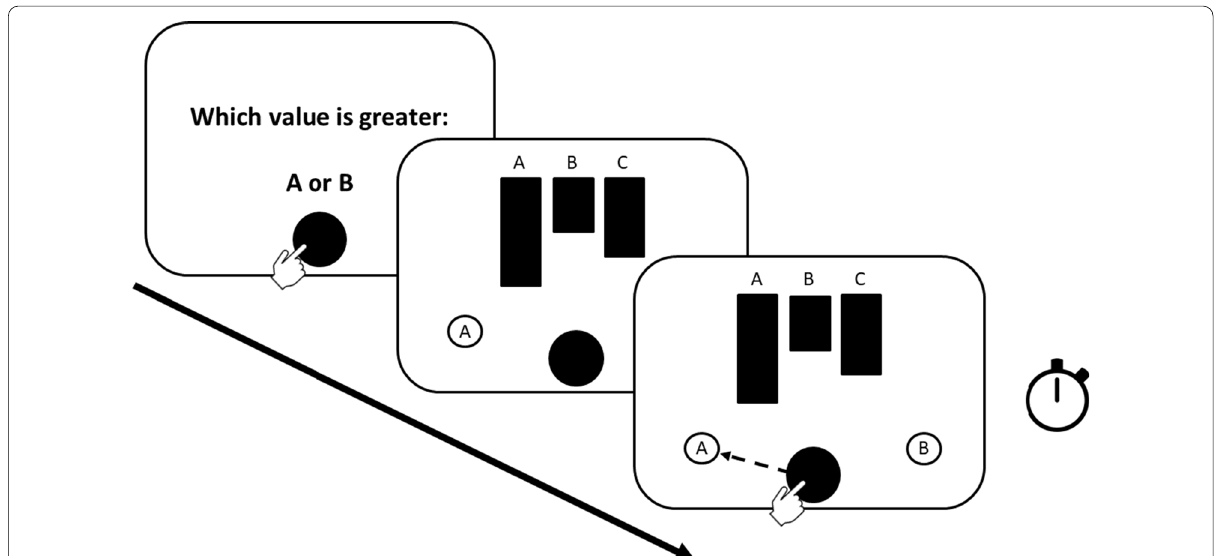
Fig. 4 Experiment 1 flow diagram. For each trial, participants were first presented with a question. After putting their finger on the button, a diagram for answering the question appeared. Participants gave their response by sliding the button onto one of two options. The time to start the movement of the correct trials was taken as the dependent